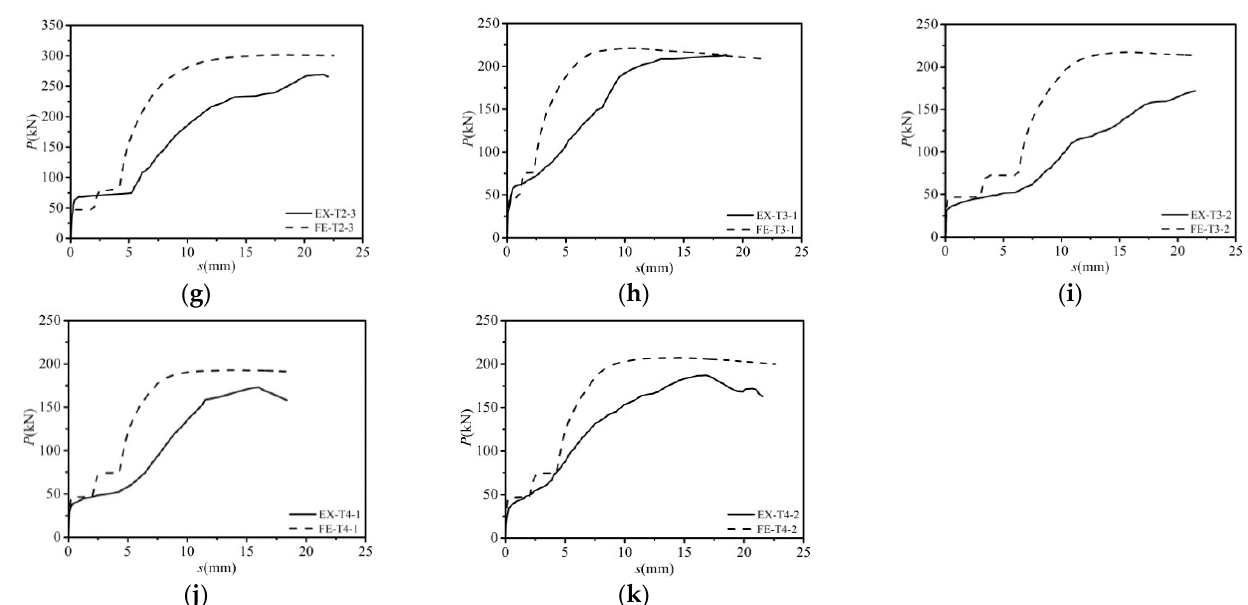
Figure 6. Comparison of load–slip curves between tests (Reprint with permission [19]; Copyright Year 2021, Publisher: Elsevier) and FE results: ( a ) T1-1; ( b ) T1-2; ( c ) T1-3; ( d ) T1-4; ( e ) T2-1; ( f ) T2-2; ( g ) T2-3; ( h ) T3-1; ( i ) T3-2; ( j ) T4-1; ( k ) T4-2.